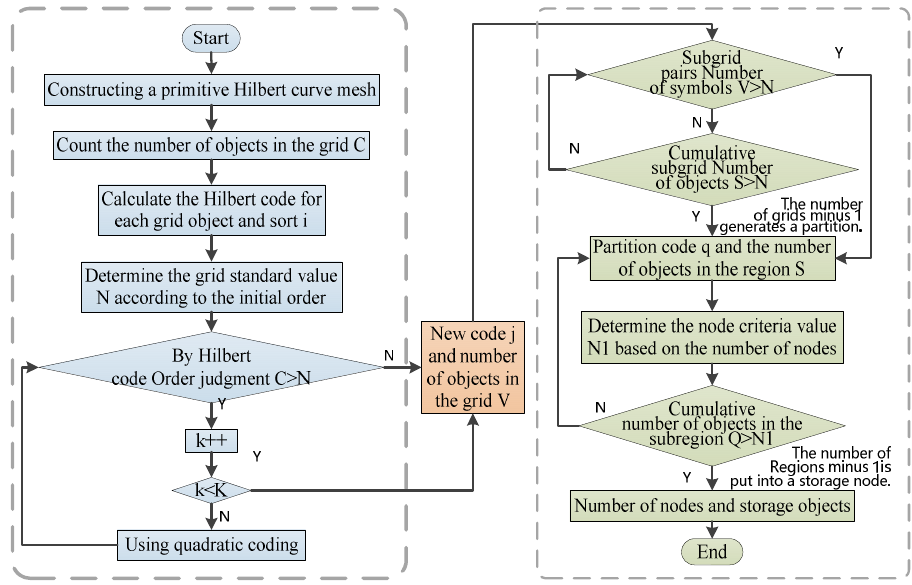
Figure 5. Spatial data partitioning algorithm flow based on Hilbert curve hierarchical decomposition.